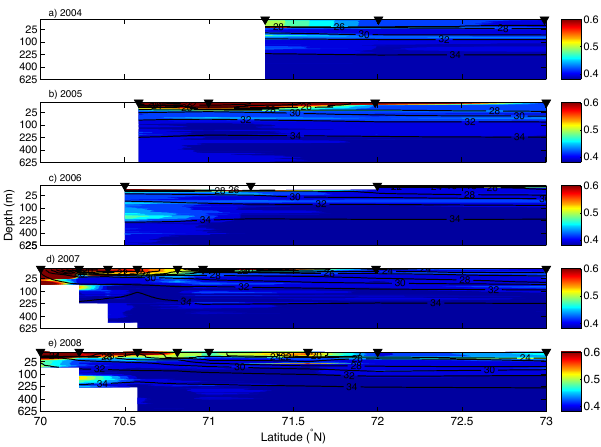
Fig. 8. An interannual comparison of beam attenuation coefficient (in m − 1 ) from a section along the longitude 140 ◦ W in the eastern Beaufort shelf region for the years (a) 2004, (b) 2005, (c) 2006, (d) 2007, and (e) 2008. This section was not sampled in 2003. Here, the vertical axis is nonlinear (square root) to emphasize the near-surface features. The black lines show isohalines at 2 salinity unit intervals. The black triangles represent station locations for each year. Note that the attenuation range is about double that in Fig.